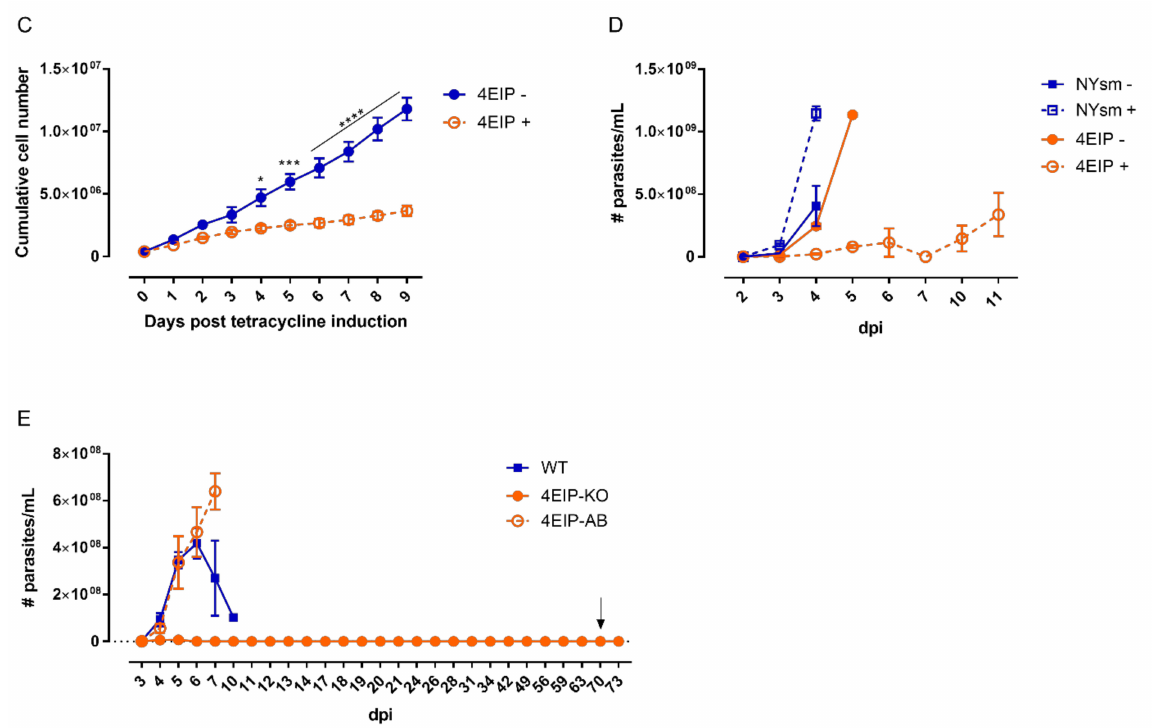
Figure 6. The role of ADKIN and 4EIP in parasite growth and infectivity. Impact of ADKIN RNAi-mediated knockdown on ( A ) in vitro growth and ( B ) and in vivo infectivity. Impact of 4EIP RNAi-mediated knockdown on ( C ) in vitro growth and ( D ) and in vivo infectivity. ( E ) Impact of 4EIP knockout (4EIP-KO) and add-back (4EIP-AB) on in vivo infectivity. The arrow indicates the moment of immunosuppressive treatment. Results are expressed as the average cell numbers, and error bars represent the SEM. The in vitro experiments are based on two independent experiments ( n = 2), each with two biological replicates. + = tetracycline-induced clones; − = non-induced clones. The in vitro cumulative growth curves were performed with two independently generated RNAi clones. * p < 0.01, *** p < 0.001, **** p <